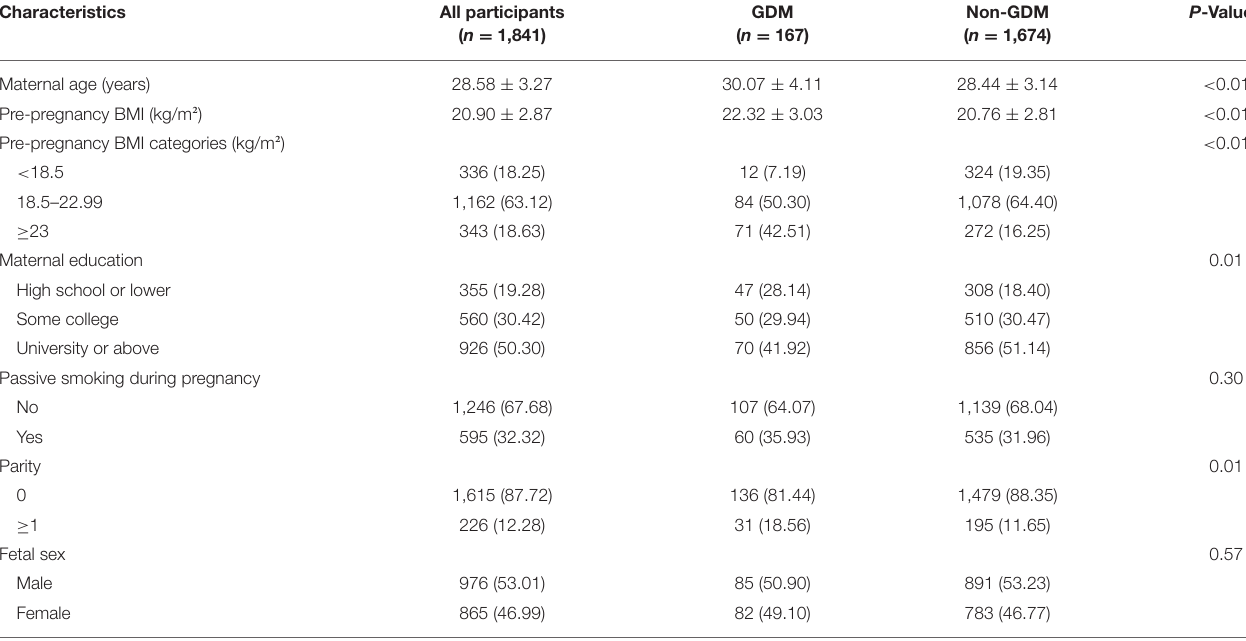
TABLE 1 | Characteristics of 1,841 participants in this study.